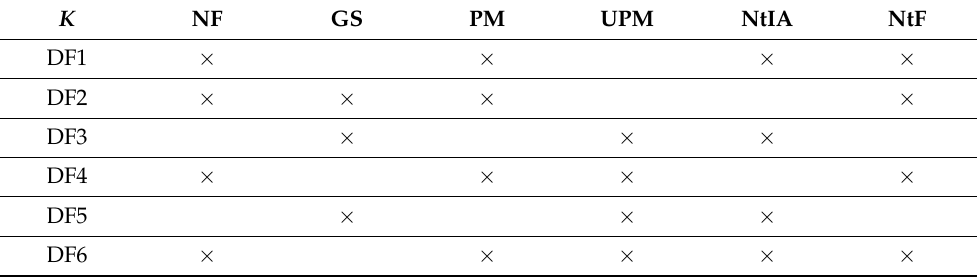
Table 2. The formal context K built from the raw data given in Table 1. Each column name is abbrevi- ated (i.e., NF, GS, PM, UPM, NtIA, and NtF stand for natural_forage , growth_stimulant , pasteurised_milk , unpasteurised_milk , nextTo_industrialAreas , and nextTo_Forests ,